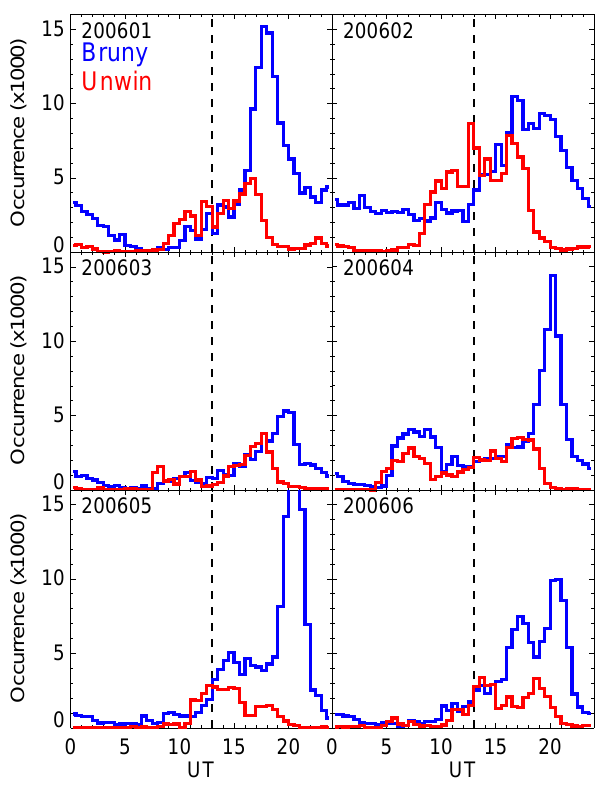
Fig. 2. The number of echoes detected by each TIGER radar as a function of Universal Time summed over all days for each month in the first half of 2006. The blue (red) curve corresponds to measure- ments made by the Bruny Island (Unwin) radar. Magnetic midnight ( ∼ 13:00UT) is indicated on each plot by the dashed vertical